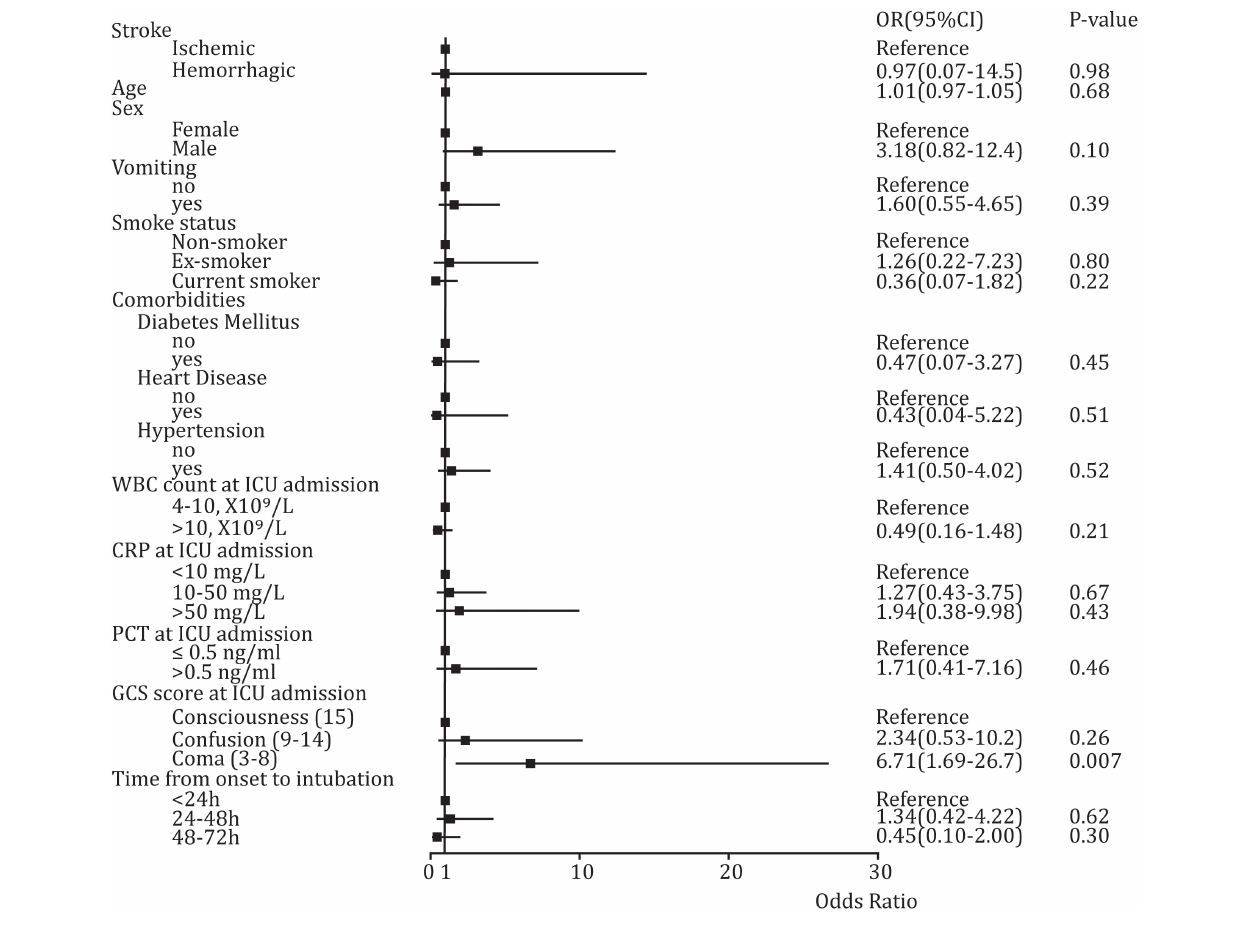
FIGURE 3 | Forest plot of Logistic regression analysis, describing the potential predictors for